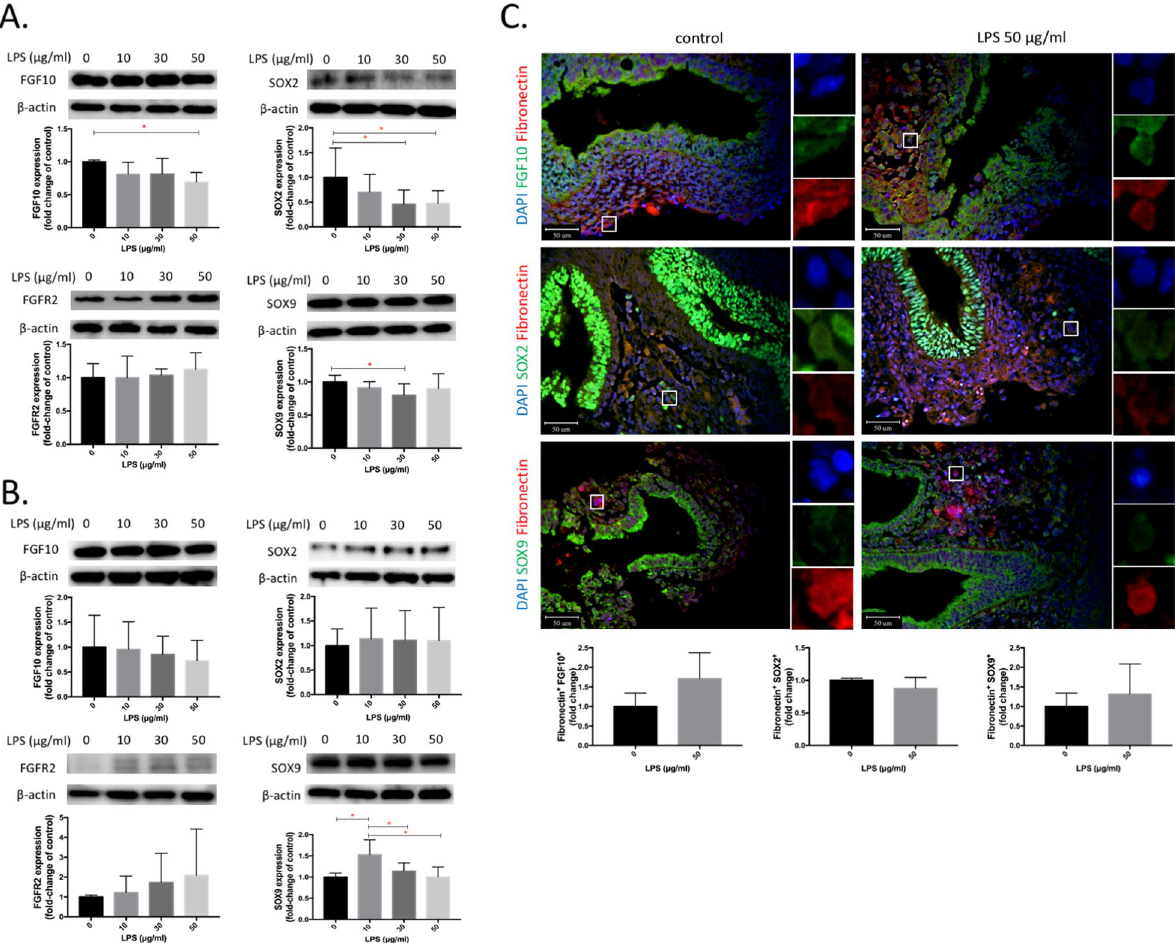
Fig. 4 Expressions of fibroblast growth factor 10 (FGF10), FGF receptor 2 (FGFR2), SRY‑box transcription factor 2 (SOX2), and SOX9 in IMR‑90 cells, ex vivo fetal lungs, and fibroblasts of ex vivo fetal lungs by lipopolysaccharide (LPS). A Expressions of FGF10, FGFR2, SOX2, and SOX9 in IMR‑90 cells by LPS at 0, 10, 30, and 50 μg/ml for 24 h ( n 6). B Expressions of FGF10, FGFR2, SOX2, and SOX9 in whole fetal lungs by LPS at 0, 10, 30, and = 50 μg/ml for 3 days ( n 6). C Expressions of fibronectin + FGF10, SOX2, and SOX9 of fetal lungs by LPS at 0 and 50 μg/ml for 3 days. DAPI (in blue). = Fibronectin (in red). FGF10, SOX2, and SOX9 (in green) ( n 3). *p < =